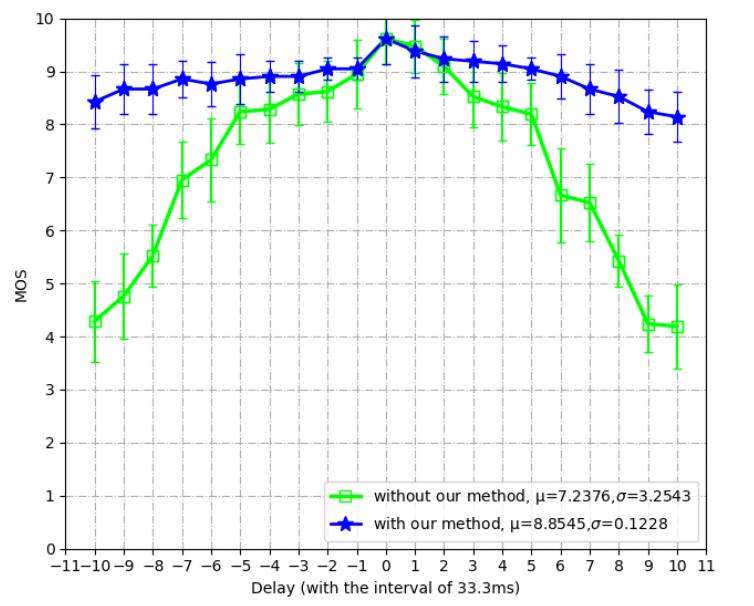
Figure 10. The subjective improvements with our